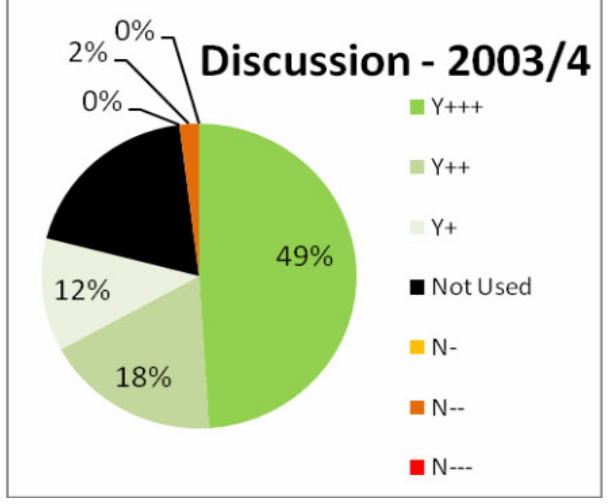
Figure 5. Discussions in 2003/4